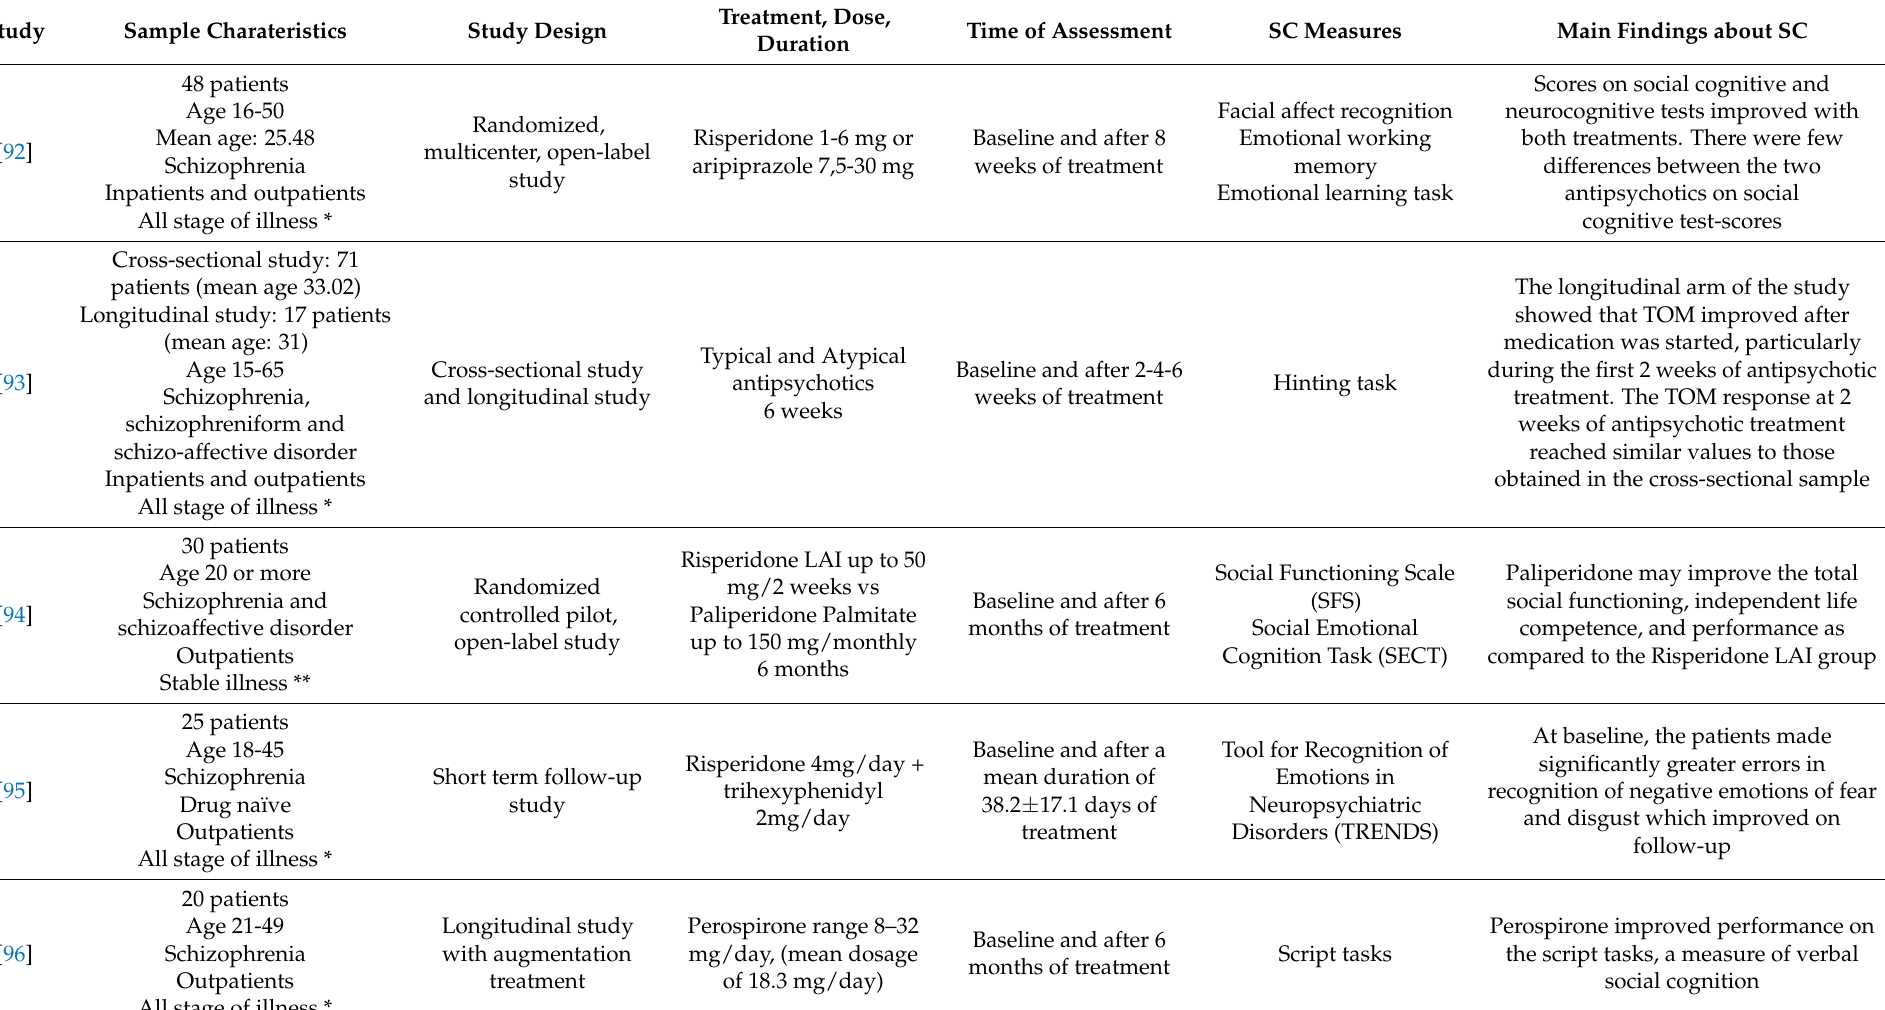
Table 1. Original contributions about studies that investigate pharmacological treatment in SZ in relation to SC